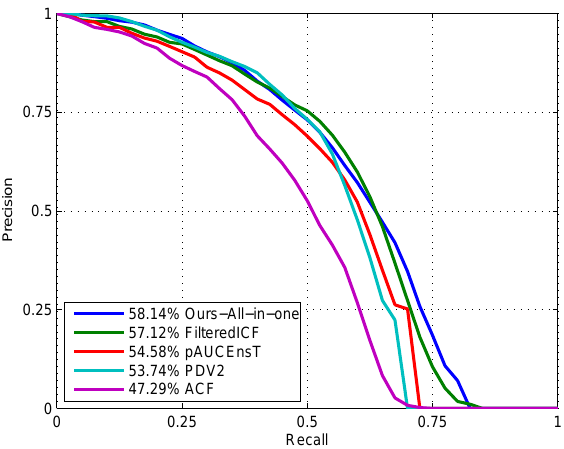
Figure 8. Comparison with non deep learning methods on the KITTI dataset. Our method does not achieve the highest precision for the whole recall range, but based on AP, our method outperforms the other